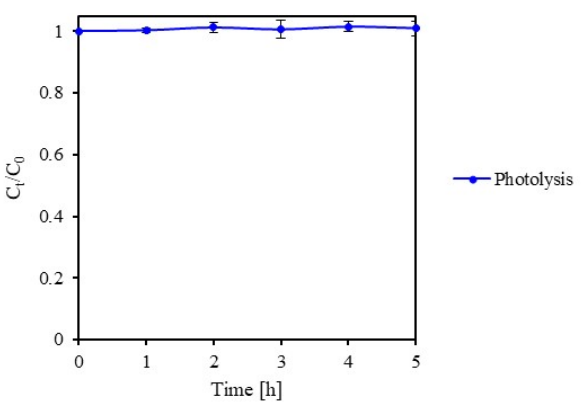
Figure 7. Methylene blue photolysis curve during 5 h of UV light Figure 7 . Methylene blue photolysis curve during 5 h of UV light irradiation.